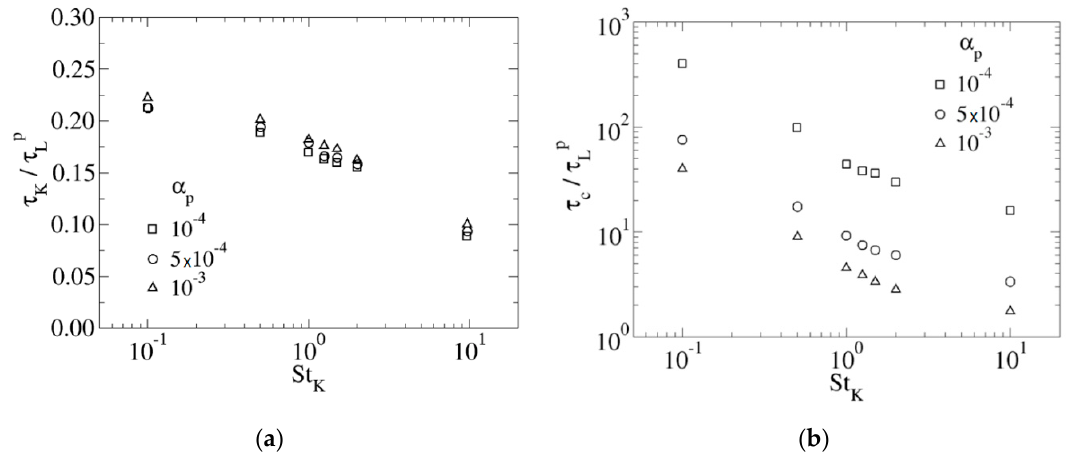
Figure 6. Kolmogorov time scale over particle Lagrangian time scale ( a ) and inter-particle collision time over particle Lagrangian time scale ( b ) as a function of particle Stokes number for the three evaluated average volume fractions.